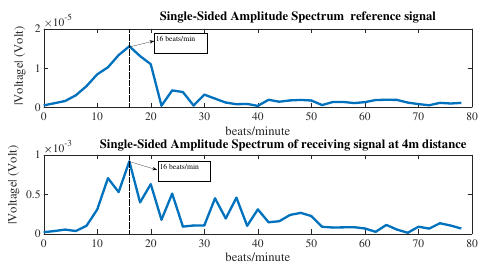
Figure 9. Receiving signals in frequency domain.